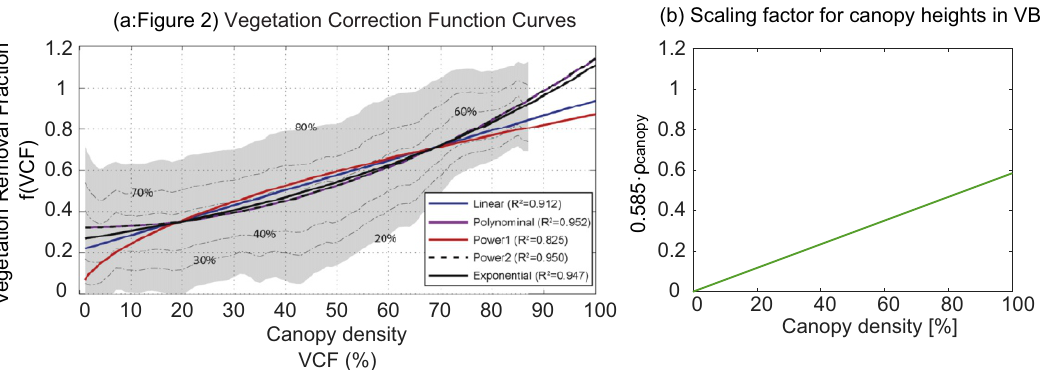
Figure 16. Fraction of canopy height that is removed by: ( a ) Functions investigated in O’Loughlin et al., 2016 [2] in Figure 2. ( b ) The equivalent for VB3 as a ρ canopy , plotted over the same